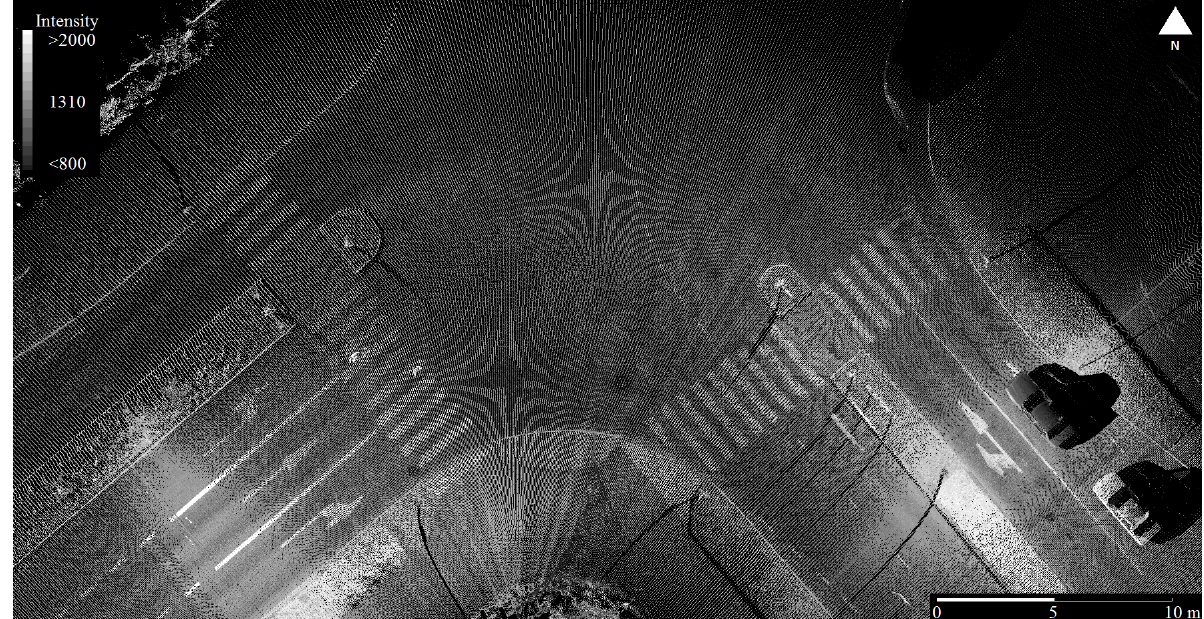
Figure 3. Vehicle-mounted MLS data with intensity-scale coloring of a street corner; besides street geometry, intensity data enable identification of road paintings such as zebra